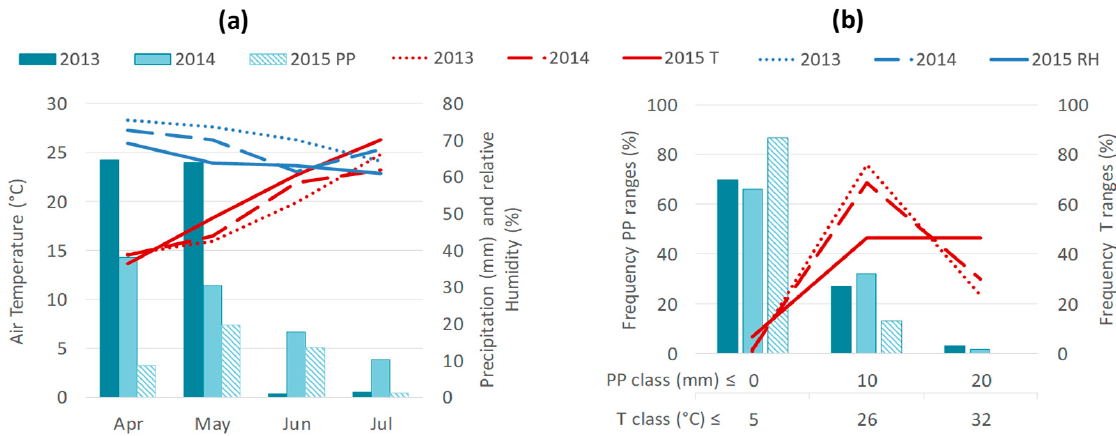
Figure 10. Cumulated precipitation (PP), average air temperature (T), and relative humidity (RH) during the study seasons ( a ); frequency of days of absence, low and high precipitation (respectively, 0.10 and 20 mm), and ranges of air temperature, optimal (26 °C) and non ‐ optimal (<5 °C and ≥ 32 °C) for disease development ( b ).